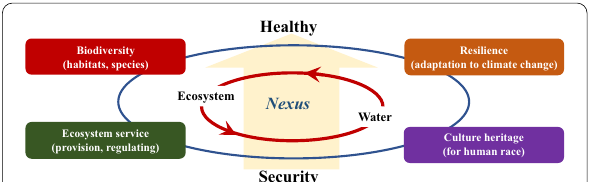
Fig. 3 Conceptual framework of “eco-water